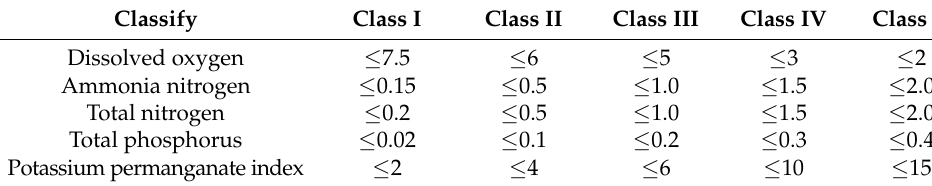
Table 2. Environmental quality standards for surface water (units of